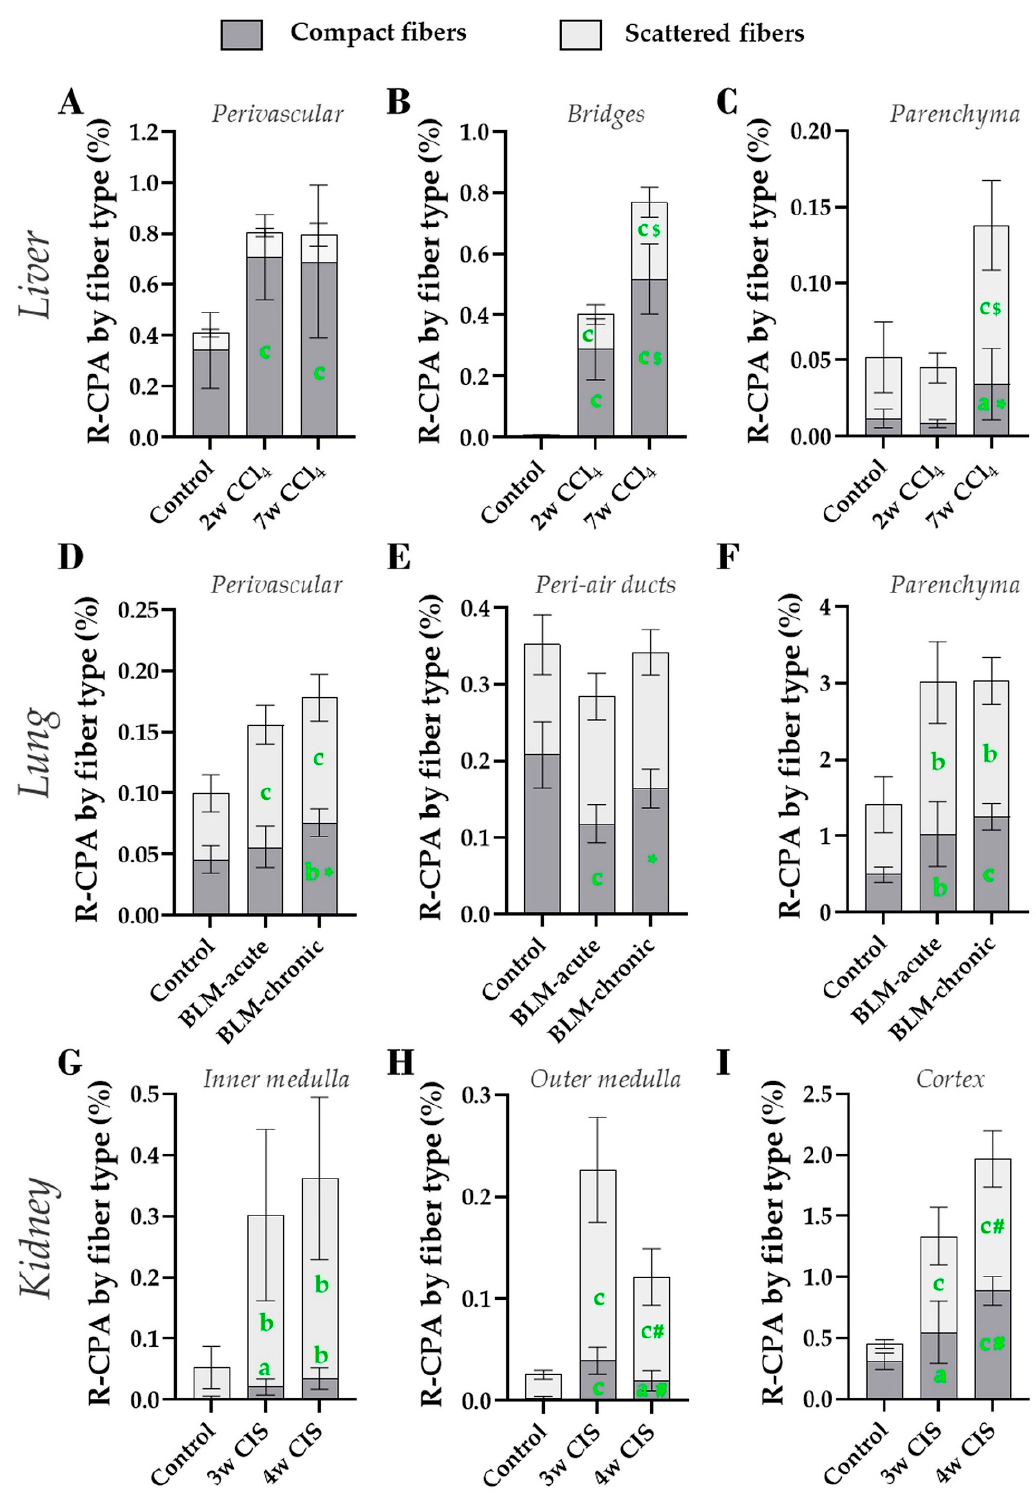
Figure 10. Regionalized analysis of compact and scattered fibers with PSR MORF detection method. Results are shown in the liver for the perivascular region ( A ), bridges ( B ), and parenchyma ( C ), in the lung for the perivascular region ( D ), the peri-air duct region ( E ), and the parenchyma ( F ), and in the kidney for the inner medulla ( G ), the outer medulla ( H ) and the cortex (vessels included) ( I ). Mean (±SD). One-way ANOVA with Fisher’s post-hoc test. a: p < 0.050, b: p < 0.010, c: p < 0.001 vs. controls; *: p < 0.050, # : p < 0.010, $ : p < 0.001 last time point vs. intermediate time point.